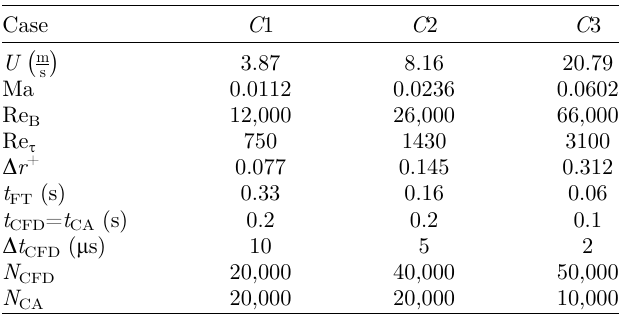
Table 1. Overview of investigated cases and CFD and CA setup details.